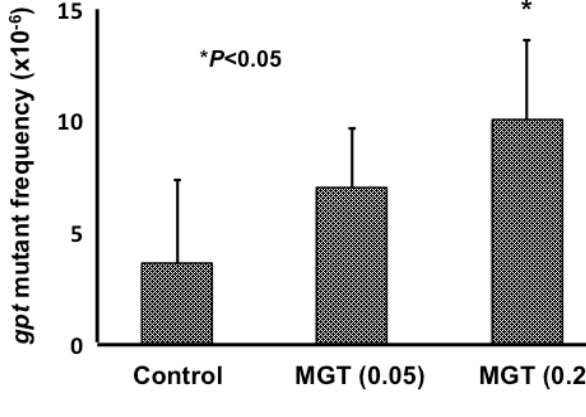
Figure 3. The gpt mutation frequencies in the lungs of mice after multiple intratracheal instillations of MGT. Male mice were treated with multiple (0.05 or 0.2 mg/mouse × 4 times) doses of MGT, and mice were sacrificed eight weeks after MGT administration. The data represent the mean ± SD; * P < 0.05 by the Student’s t -test vs. the corresponding vehicle control